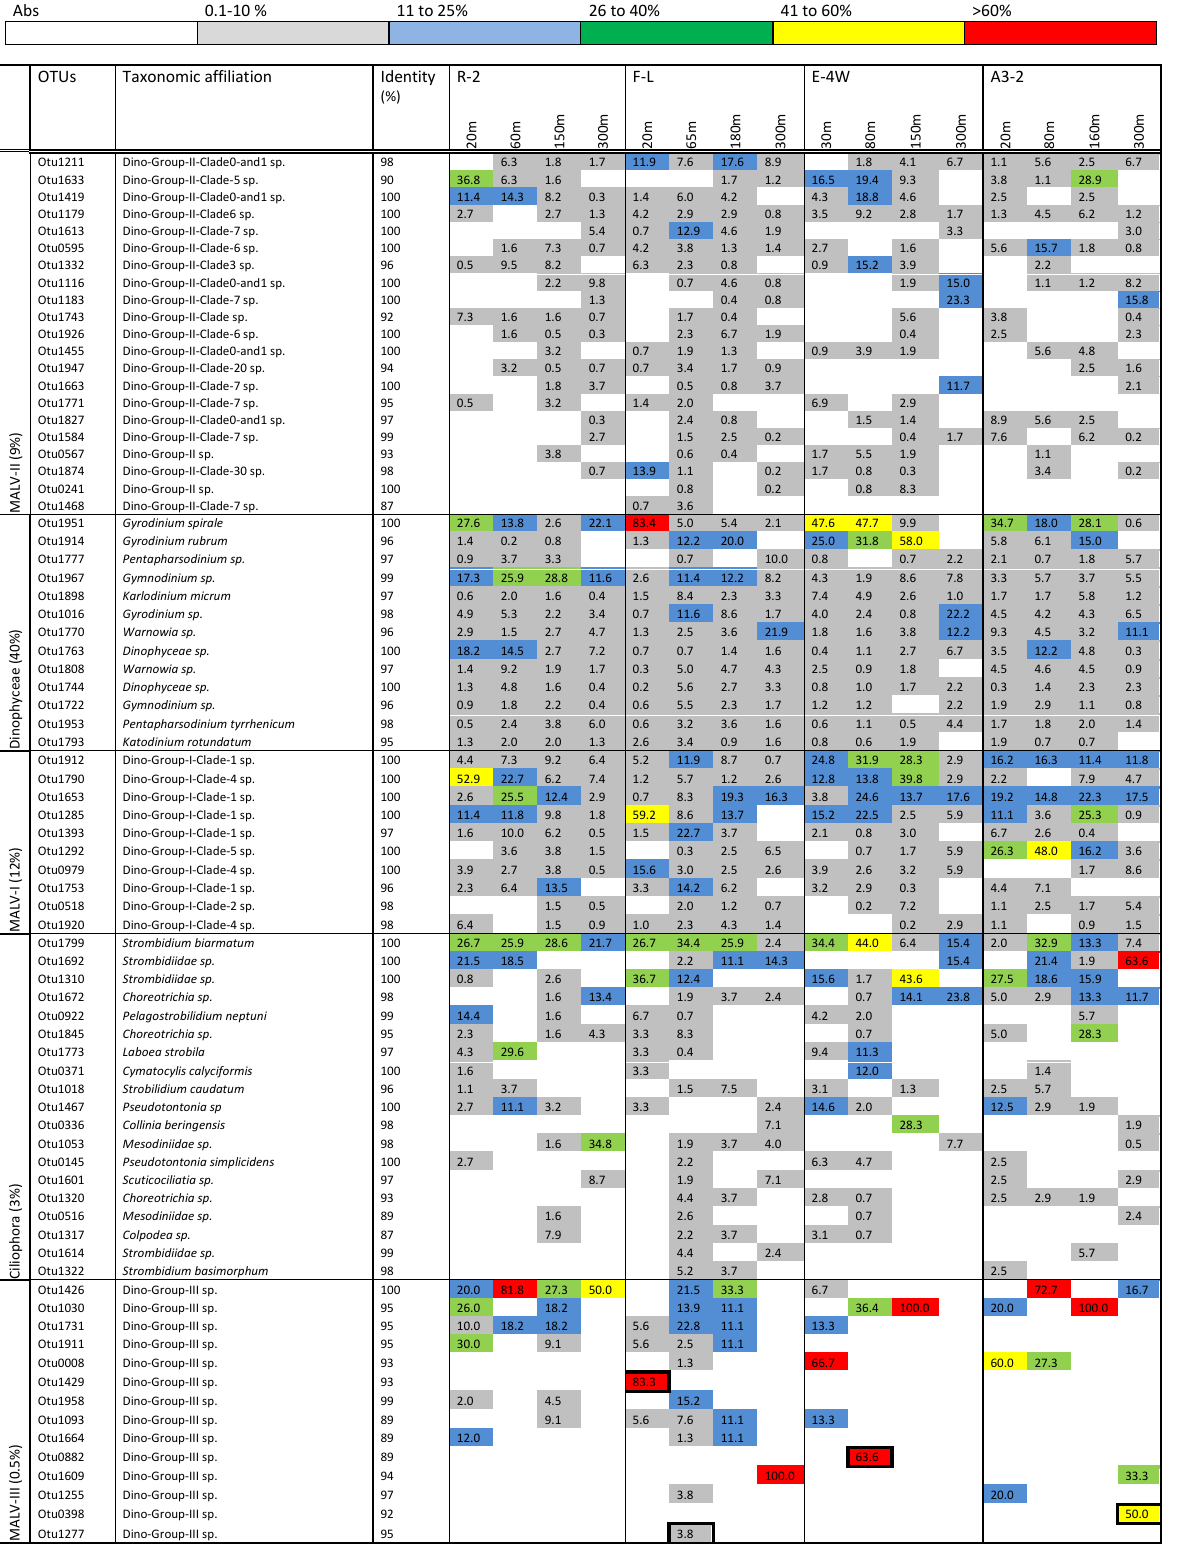
Table 4. Colour-coded heat-map table of the major taxonomic groups ( > 10OTUs) (see Table 3). The 207OTUs presented here accounted for 95% of the total sequences and represented > 1% of sequences in each taxonomic group. The colours represent the relative abundance of each OTU within each sample. White boxes indicate absence. Black contours indicate the 17OTUs found only at one station.